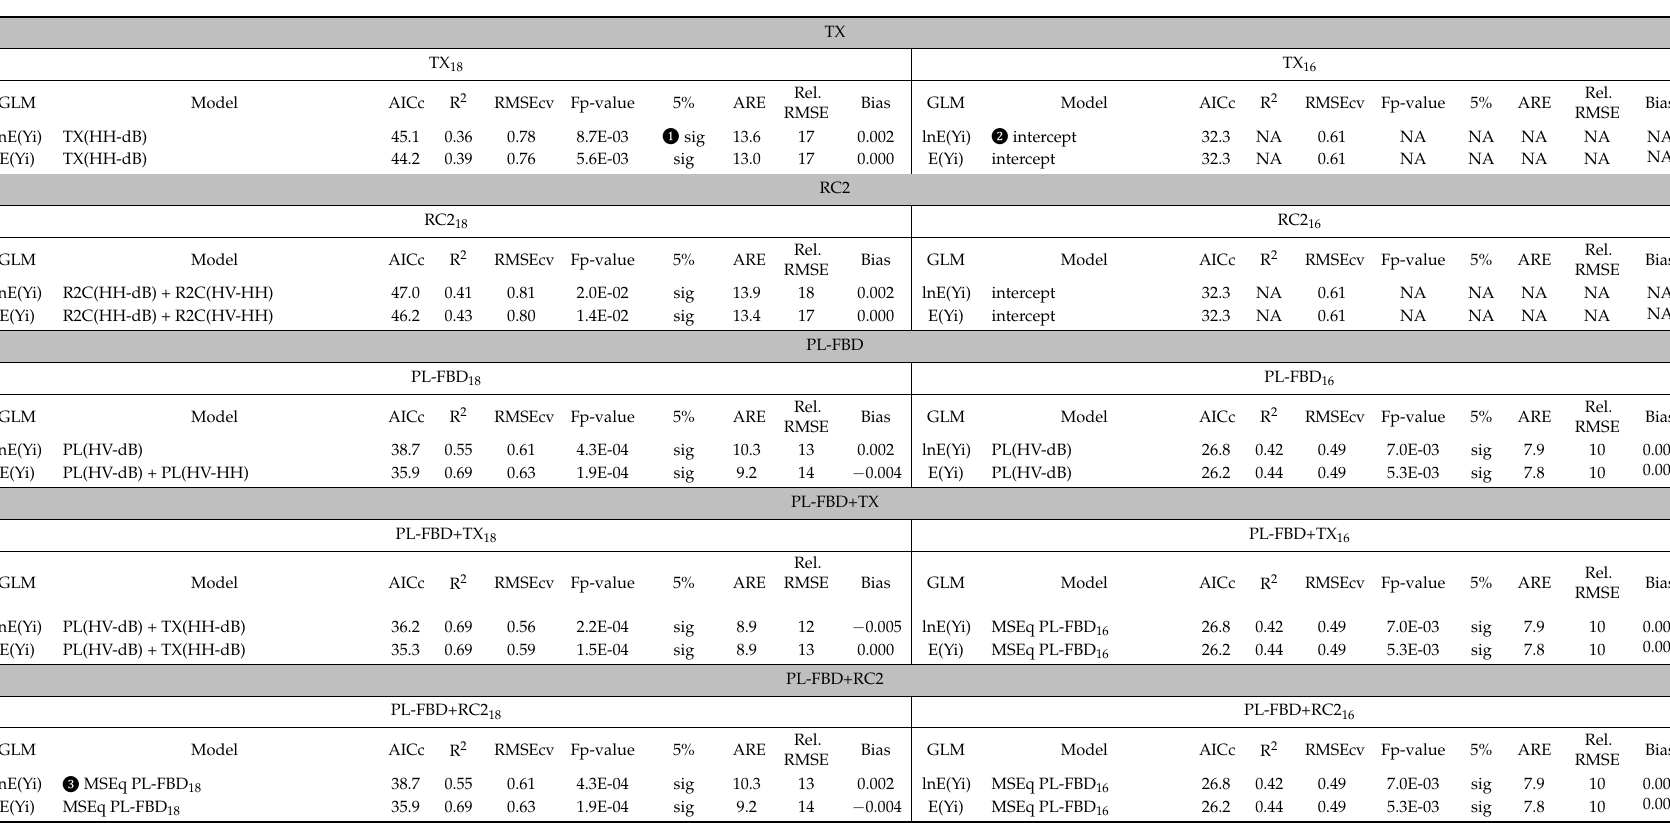
Table 4. Generalized Linear Model (GLM) specifications and model evaluation for predicting Leaf Area Index from synthetic aperture radar data in floodplain forests of the Amazon basin. TX 18 GLM Model